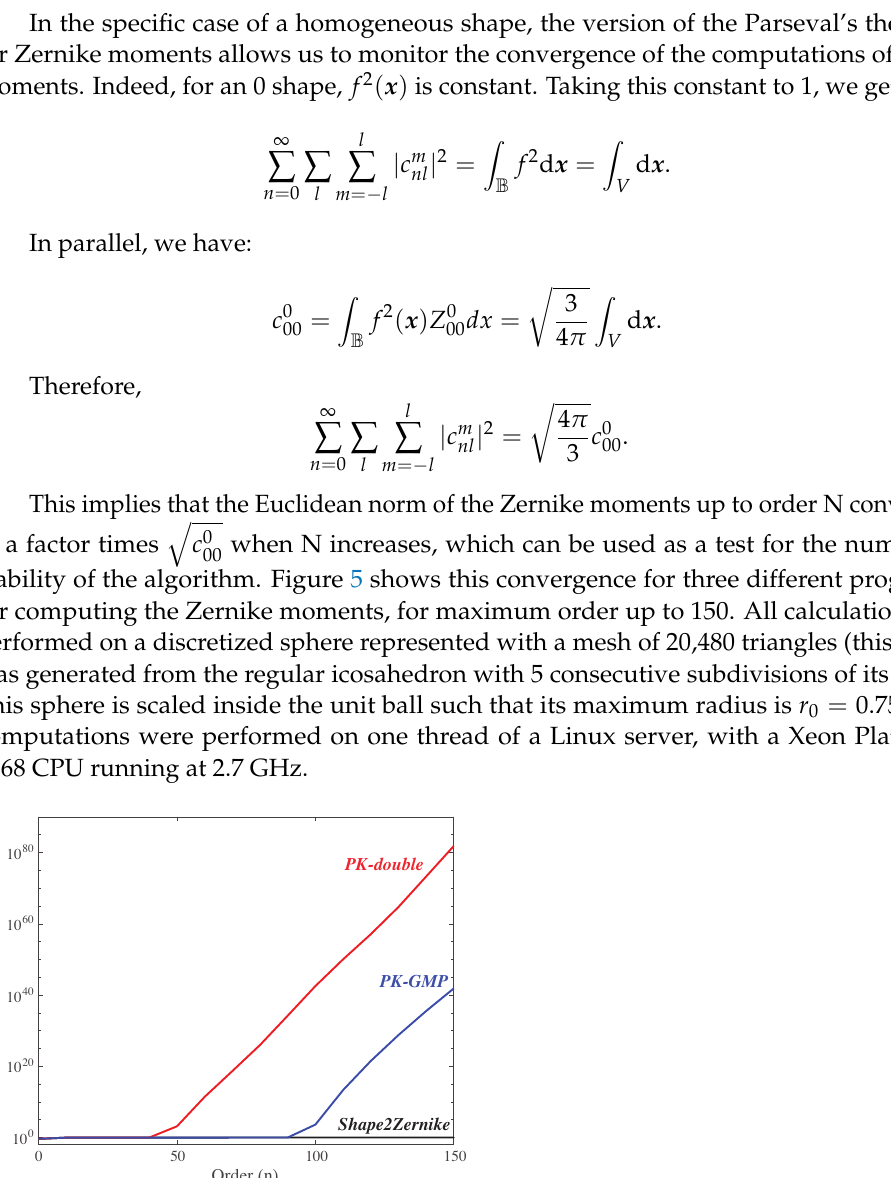
(cid:113) 4 π ; this ratio should converge to (see 00 3